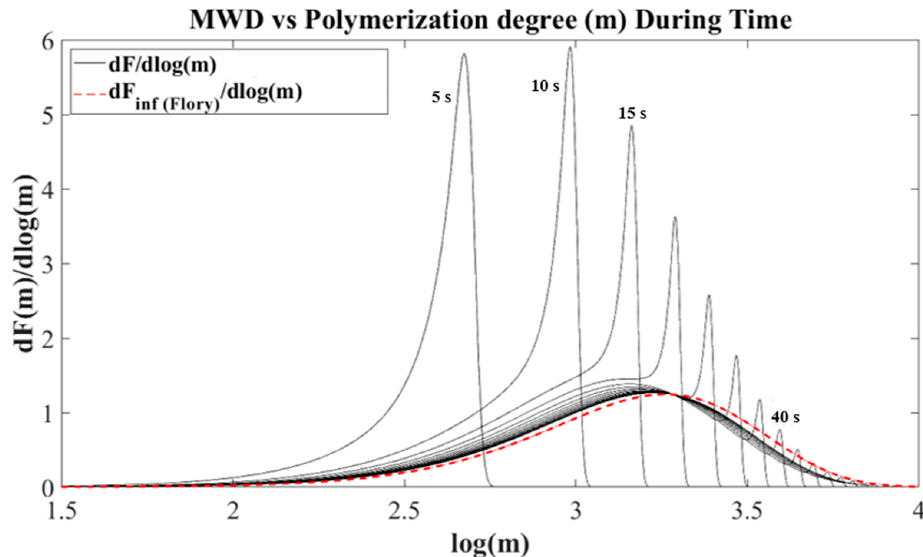
Figure 6. Molecular weight distribution according to Equations (33) and (34) ( K P = 100/s, K I = 1/s, K T = 0.1/s, K D = 0.01/s, t = 5 to 75 s by 5 s increments).